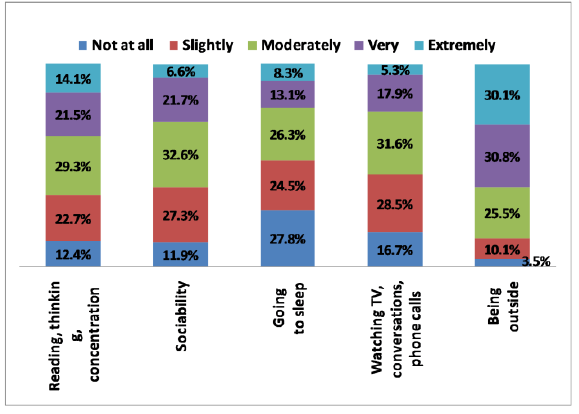
Figure 8. Comparison of education level